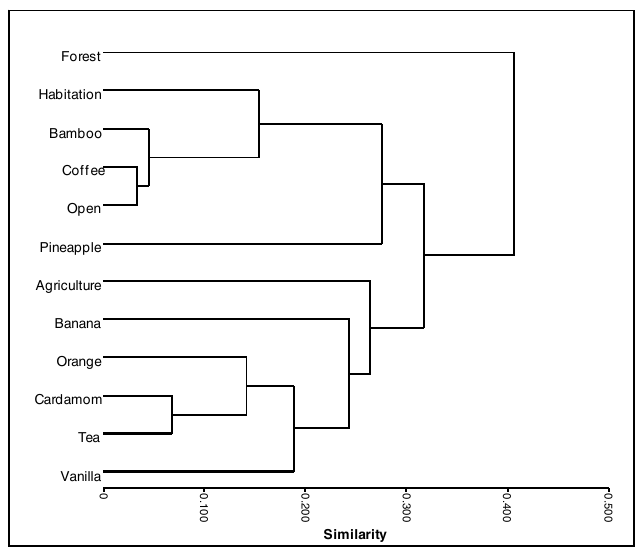
Figure 7. Single linkage clustering of abundances of non- volant small mammals across habitats using Morisitta- Horn Index of